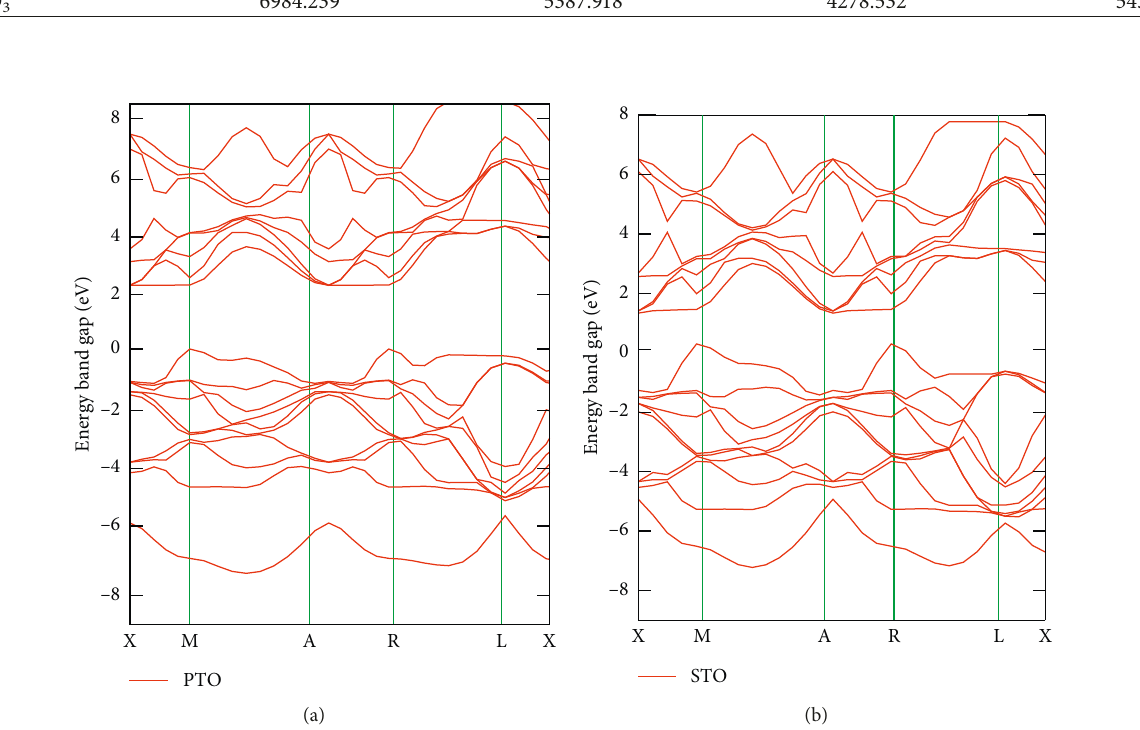
Figure 4: Electronic band structures of PbTiO